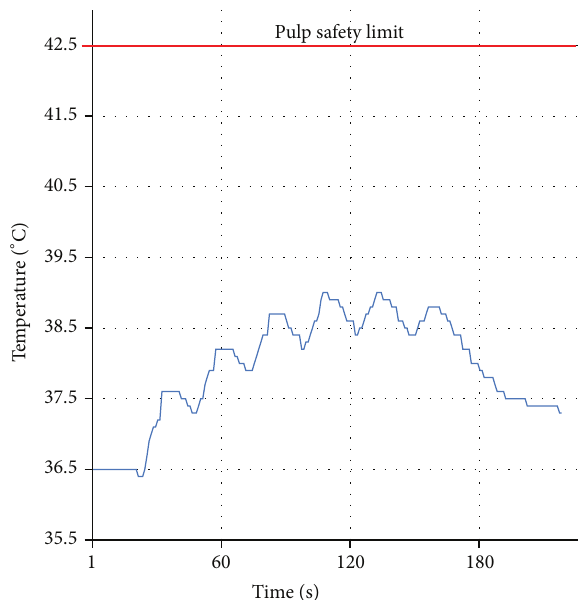
Figure 6: Temperature curve. A temperature increase of 2.5 ∘ C for the most representative sample. The six cycles of lasing are clearly visible.